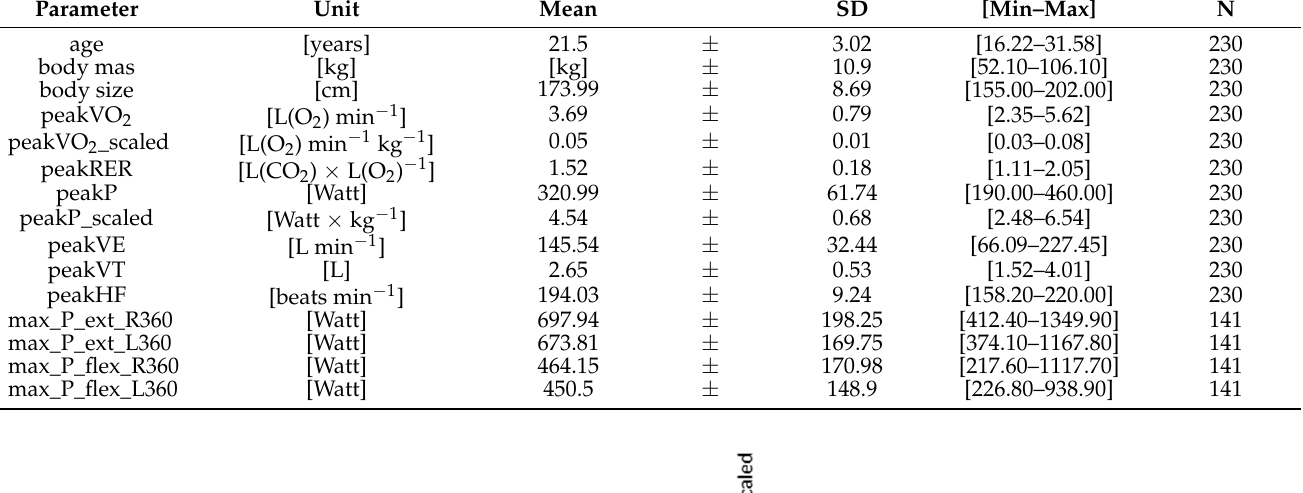
Table 2. Physiology of the studied athletes from the Swiss-ski squad. 230 data points were available, whereby a total of 168 and 62 data points were from alpine and Nordic athletes, respectively. 95 and 135 data points, respectively, were from male and female athletes.